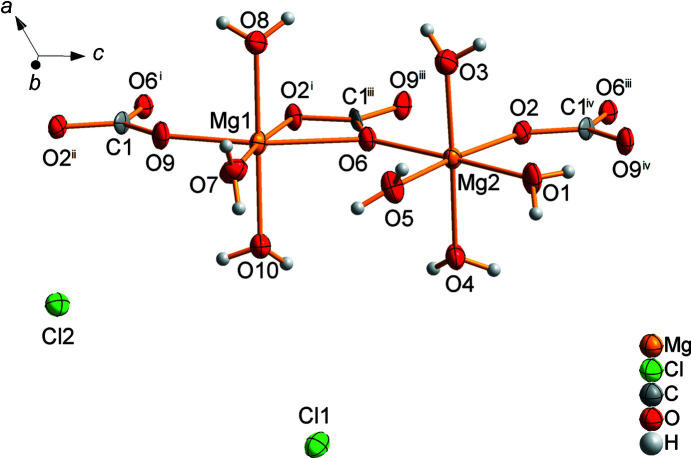
The asymmetric unit and coordination units of MgCO3·MgCl2·7H2O [symmetry codes: (i) x, −y, z − ; (ii) x, y, z − 1; (iii) x, −y, z + ; (iv) x, y, z + 1].